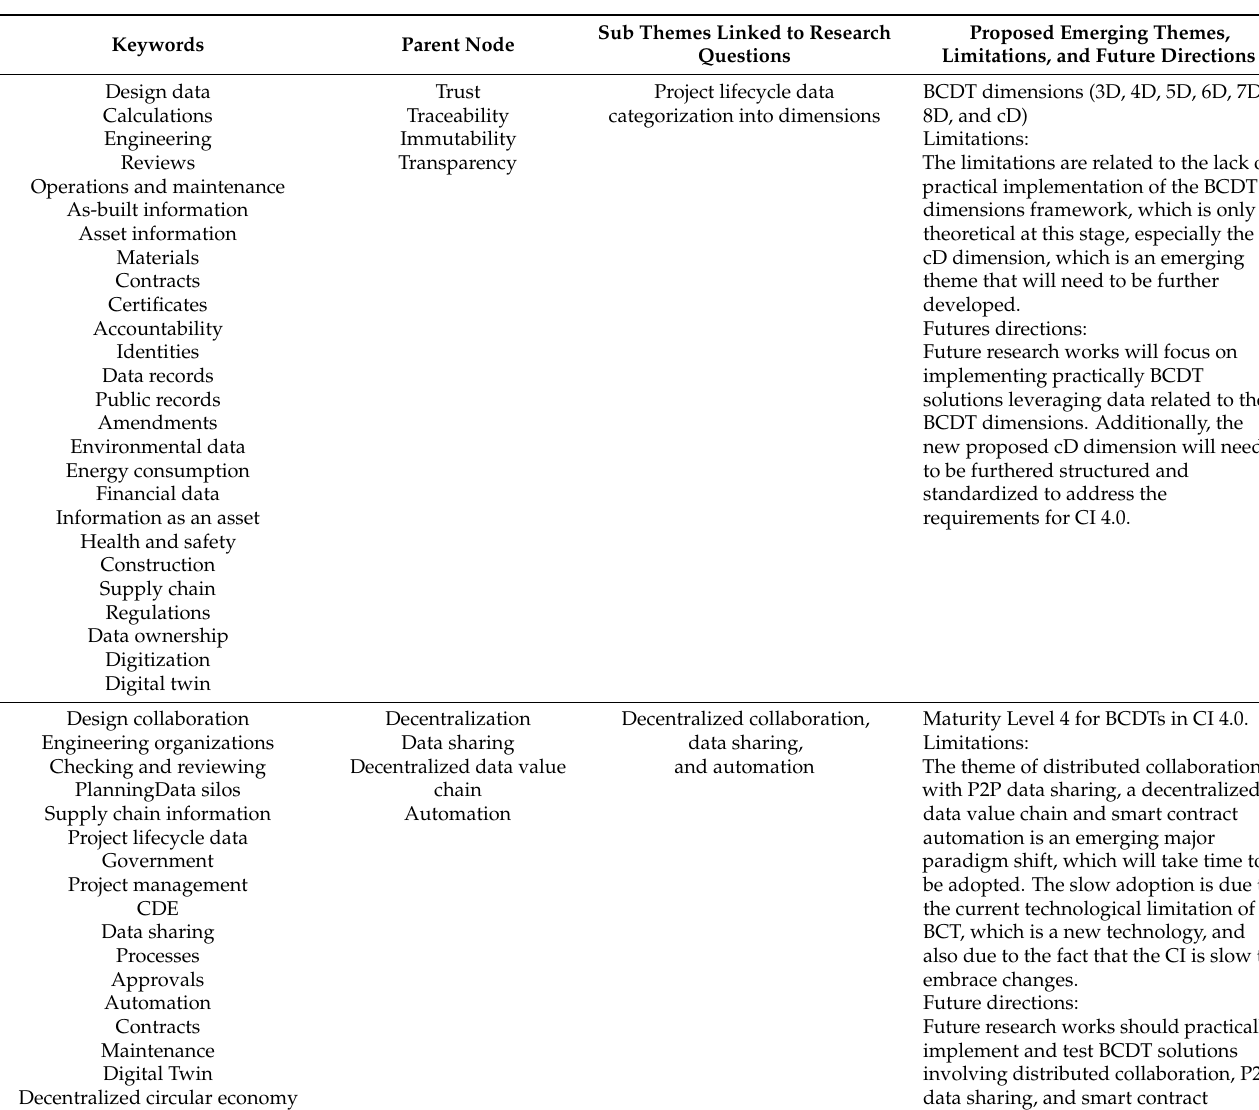
Table 15. Data analysis keywords, parent nodes, and emerging themes forming the proposed